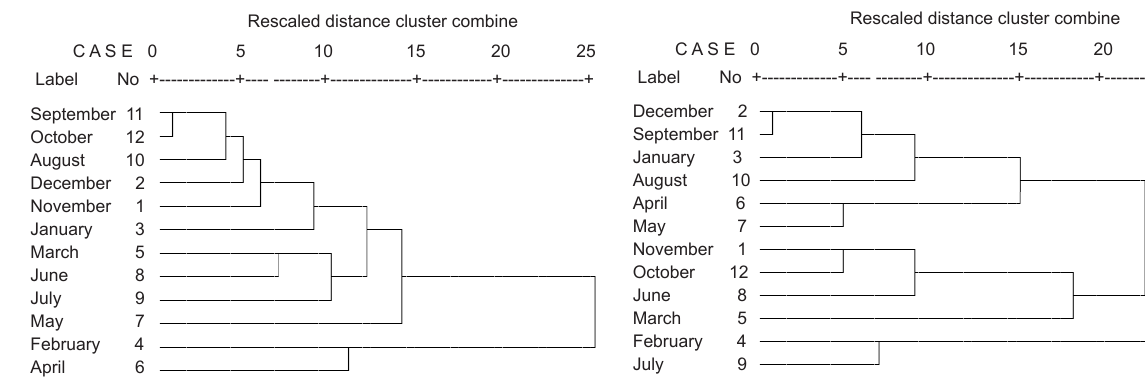
Figure 4. Hierarchical cluster analysis of Phytoplankton of Utra Pat (2003-04)